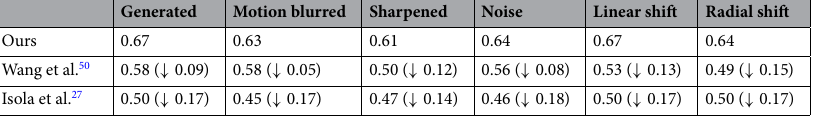
Table 2. Comparisons between structural similarity measure (SSIM) achieved by our method compared with Wang et al. 50 and Isola et al. 27 .